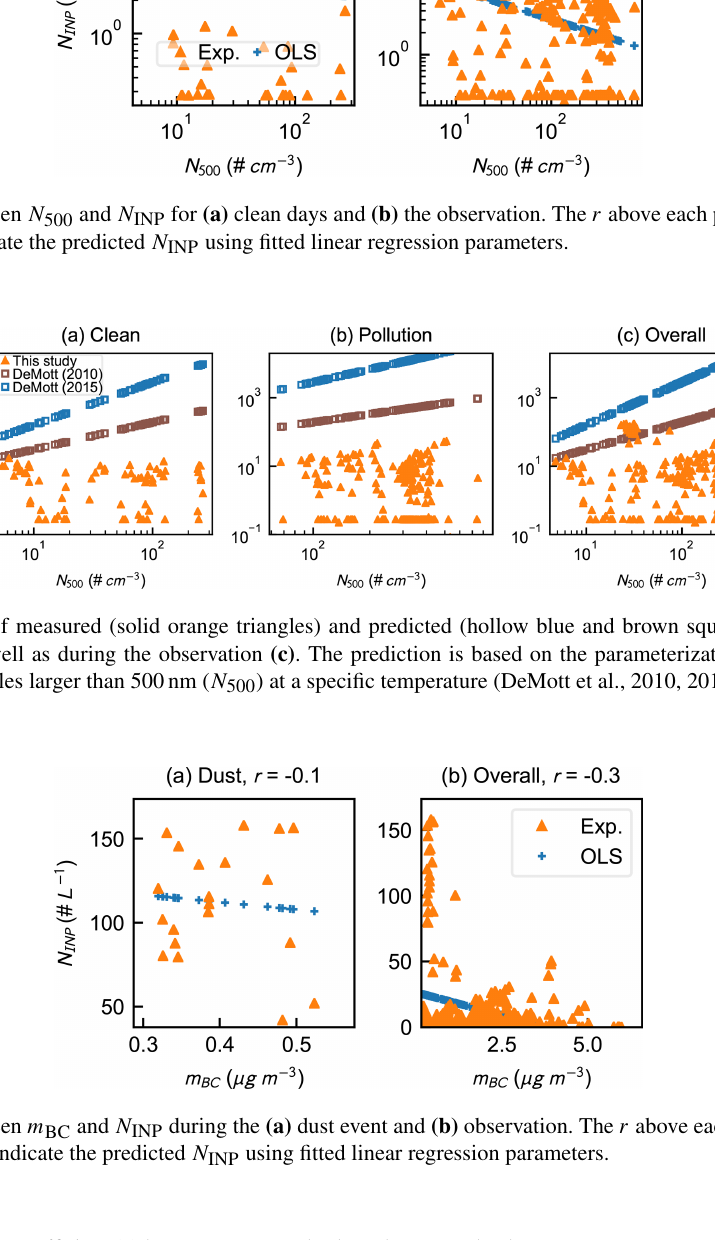
Table C1. Pearson’s correlation coefficient ( r ) between N INP and selected measured values. Measured